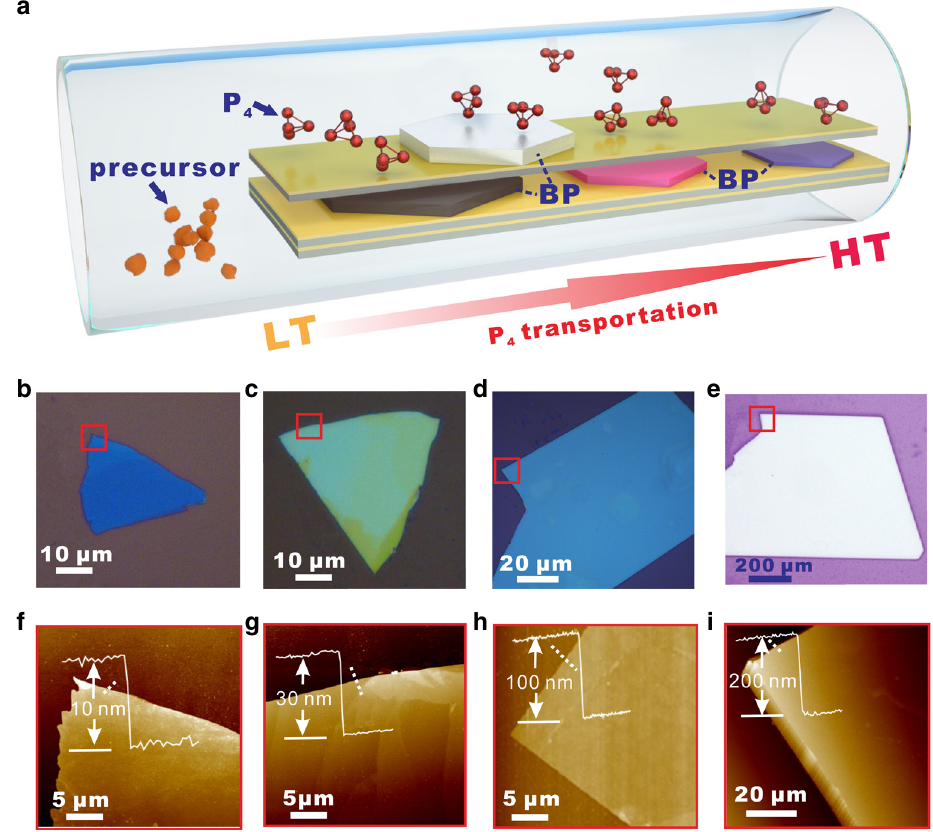
Fig. 2 Control of the lateral size and thickness of the BP fi lms during growth. a Schematic view of the experimental setup for the BP growth. Specially, the RP was evaporated to P 4 and diffused from low temperature (LT) side toward high temperature (HT) side. And, a massive of Au/Si substrates were vertically stacked and placed in the evacuated silica tube. These routes were employed for reducing the P 4 source involved in the transformation into BP. b – e BP fi lms with lateral size ranging from several micronmeter to sub-millimeter under a proper control of the temperature gradient between the source at LT and substrates at HT. f – i The corresponding AFM images indicating the thicknesses of the BP fi lms, ranging from several nanometers to hundred of